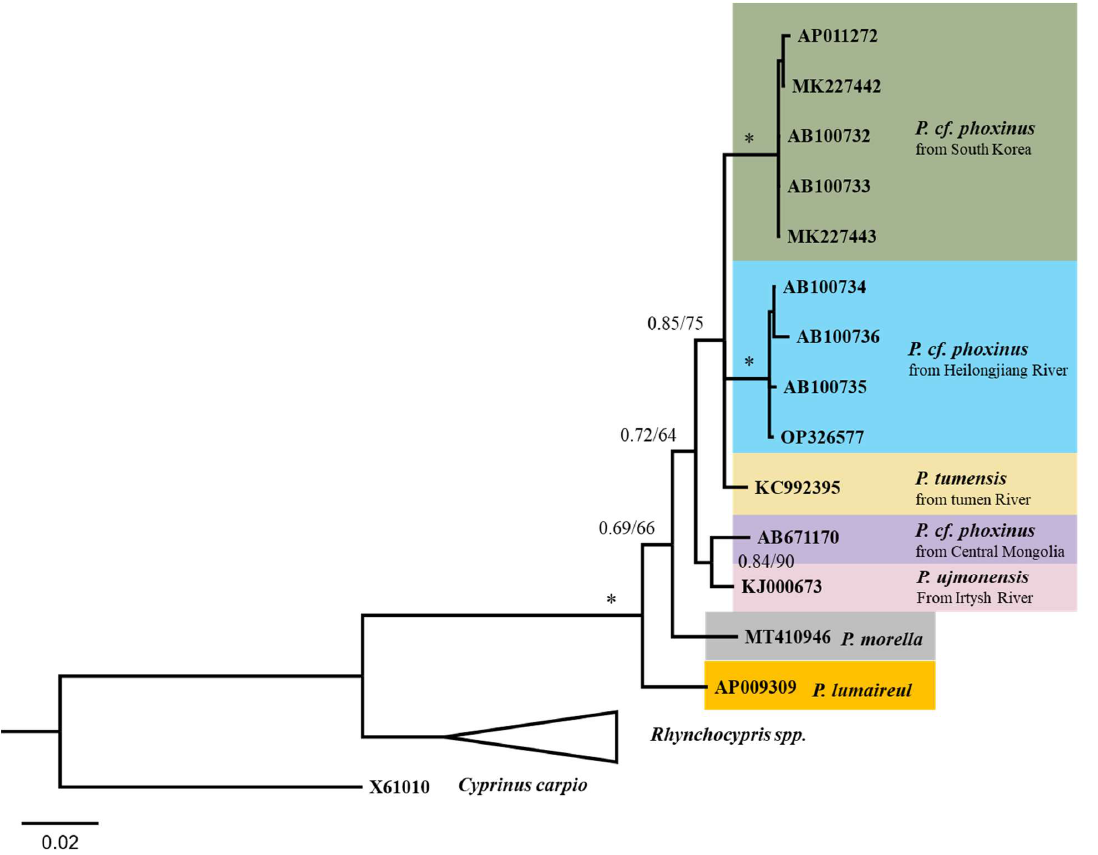
Figure 5. A Bayesian inference (BI) tree of Far Eastern phoxinins based on mtDNA 16S rRNA gene data. Posterior probability values for BI (BPP) and bootstrap values for maximum-likelihood (ML) are shown on branches. The sign ‘’*‘’ indicated BPP of 1 and Bootstrap values of 100. The 16S rRNA sequence (X61010) of Common carp ( Cyprinus carpio ) was used as the outgroup. Kottelat studied the morphology of Phoxinus spp. from Mongolia and argued that they were markedly different from European minnow ( Phoxinus phoxinus ) [1]. He also